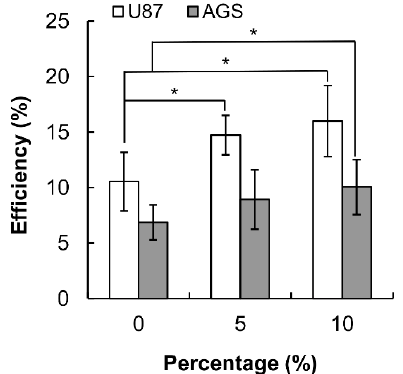
Figure 5. The percentages of AGS and U87 cells expressing the EGFP protein after transfection with PSP-PEI (at the polymer/DNA mass-to-mass ratio of 250/1) in different concentrations of FBS. (* p < 0.05; n = 5).